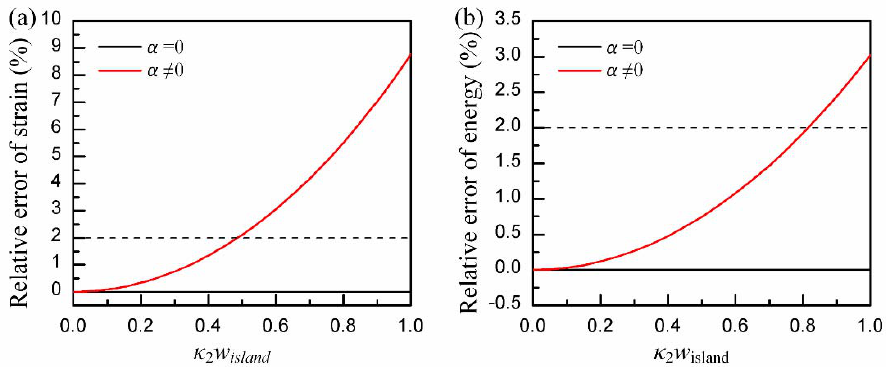
Figure A3. The relative error between approximate solution and accurate solution with κ 2 w island : ( a ) for strain and ( b ) for conformal strain energy.